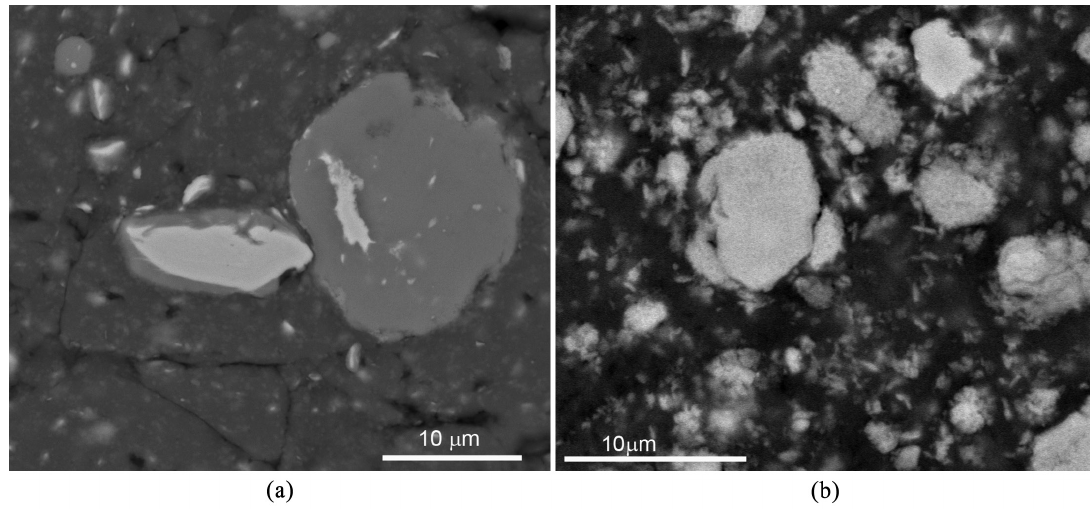
Figure 5. Backscattered image of Al_5 vol.% MA956 cold compact, heated for 24 h at 420 °C. (b) Backscattered image of Al_5 vol. %MA956 cold compact, heated for 1 h at 570 °C.